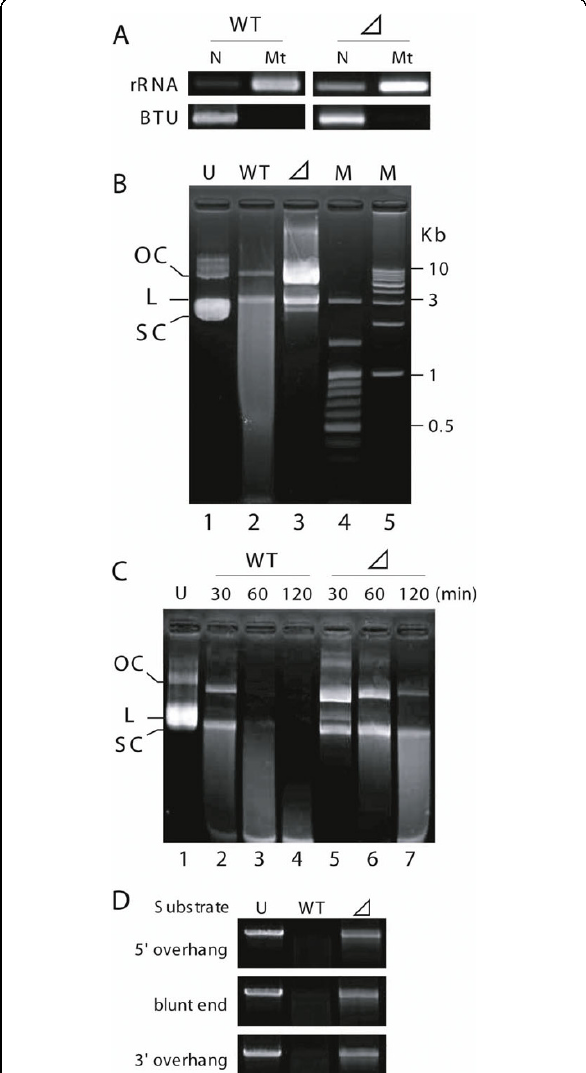
Figure 6 Mitochondrial nuclease activity . A. Fractionation PCR. A partial fragment of the mitochondrial large subunit ribosomal RNA (rRNA) or b -tubulin (BTU) was amplified by PCR, using fraction samples from wild-type and Δ AIF that contained equal amounts of DNA. N and Mt indicate nuclei/unbroken cell fraction and mitochondrial fraction, respectively. No contamination of nuclear DNA was detected in mitochondrial fraction. B. Purified mitochondria (2 μ g protein) from wild-type (lane 2) and Δ AIF (lane 3) were incubated with 2 μ g substrate plasmid DNA with a circular form for 30 min at 37°C in 30 μ l reaction buffer containing 20 mM KCl and 50 mM MOPS (pH 6.5). Lane 4 (M) and 5 (M) indicate 100- bp ladder size marker and l HindIII-digest, respectively. The substrate DNA appears in the nicked open circular (OC), linear (L), and supercoiled (SC) forms. C. The nuclease assay was performed under various incubation times. Lane 2-4, substrate DNA was coincubated with wild-type mitochondria. Lane 5-7, substrate DNA was coincubated with Δ AIF mitochondria. Undigested sample is seen in lane 1. D. Substrate specificity of the activities. End forms of linear plasmids with 5 ’ - or 3 ’ -overhang or with blunt ends are indicated at the left of